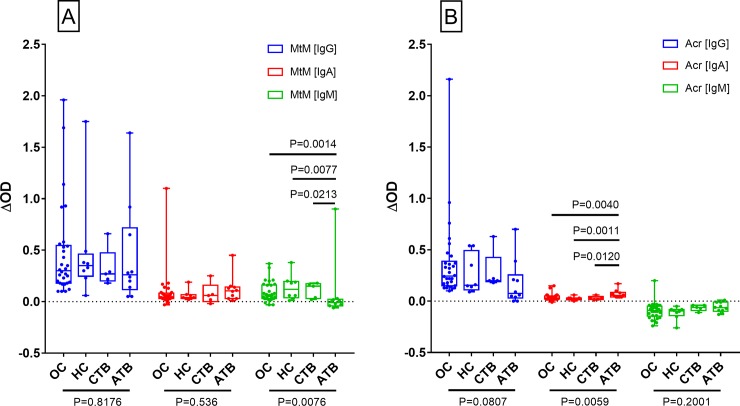
Levels (ΔOD) of antibody isotypes (IgG, IgA and IgM) against MtM (panel A) and Acr (panel B) in HCWs (OC, n = 30; HC, n = 8; and CTB, n = 5) and ATB patients (n = 10). Each column shows individual values (dots) along with median and IQR (boxes). Whiskers connect minimum and maximum values. P values (< 0.05 considered as significant) for multiple comparisons (Kruskal-Wallis test) for each Ig class across 4 groups and 2 antigens are shown below x axis (below the horizontal lines). P values for differences within the groups (Mann-Whitney test) which had shown significant differences in Kruskal-Wallis test are given on top of corresponding columns.